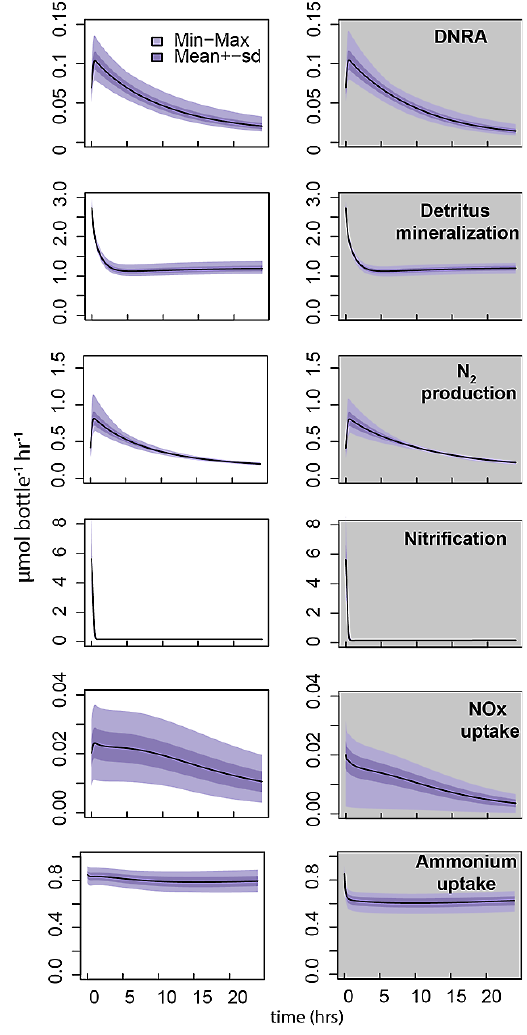
Fig. 6. Process rates derived from model. Left: rates in light, right side: rates in dark